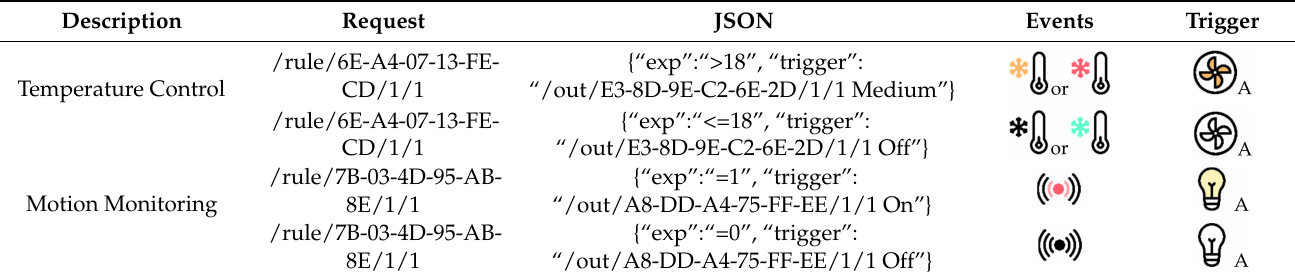
Table 5. Two-dimensional virtual environment devices: event-oriented control testing scenario. Description